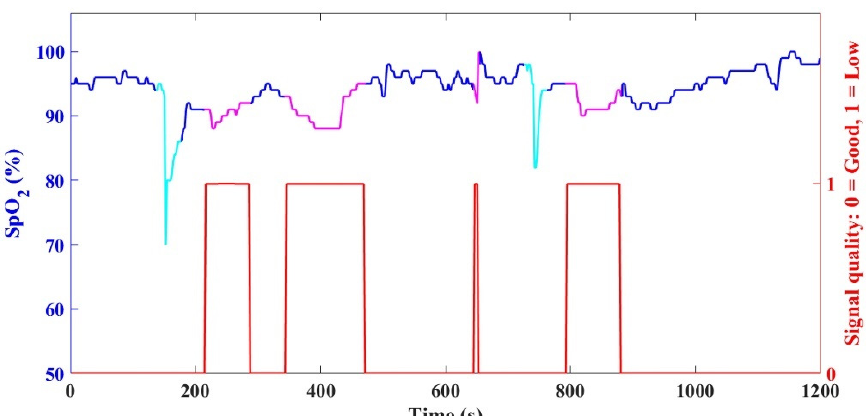
Figure 4. An example of the original raw SpO 2 data with stable parts (blue) and unstable parts (magenta and cyan). The stable parts were further processed to determine the noise, and the unstable parts were excluded due to the presence of the low-signal-quality alarm (red) or due to an abrupt change in SpO 2 (cyan) within a 30 s moving window.